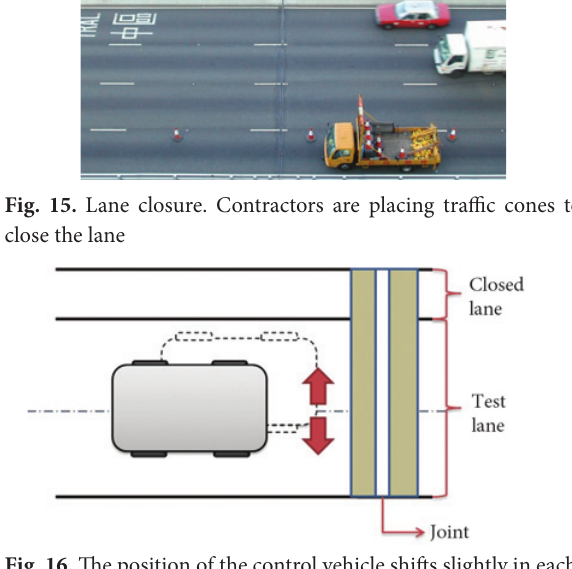
Fig. 16. The position of the control vehicle shifts slightly in each